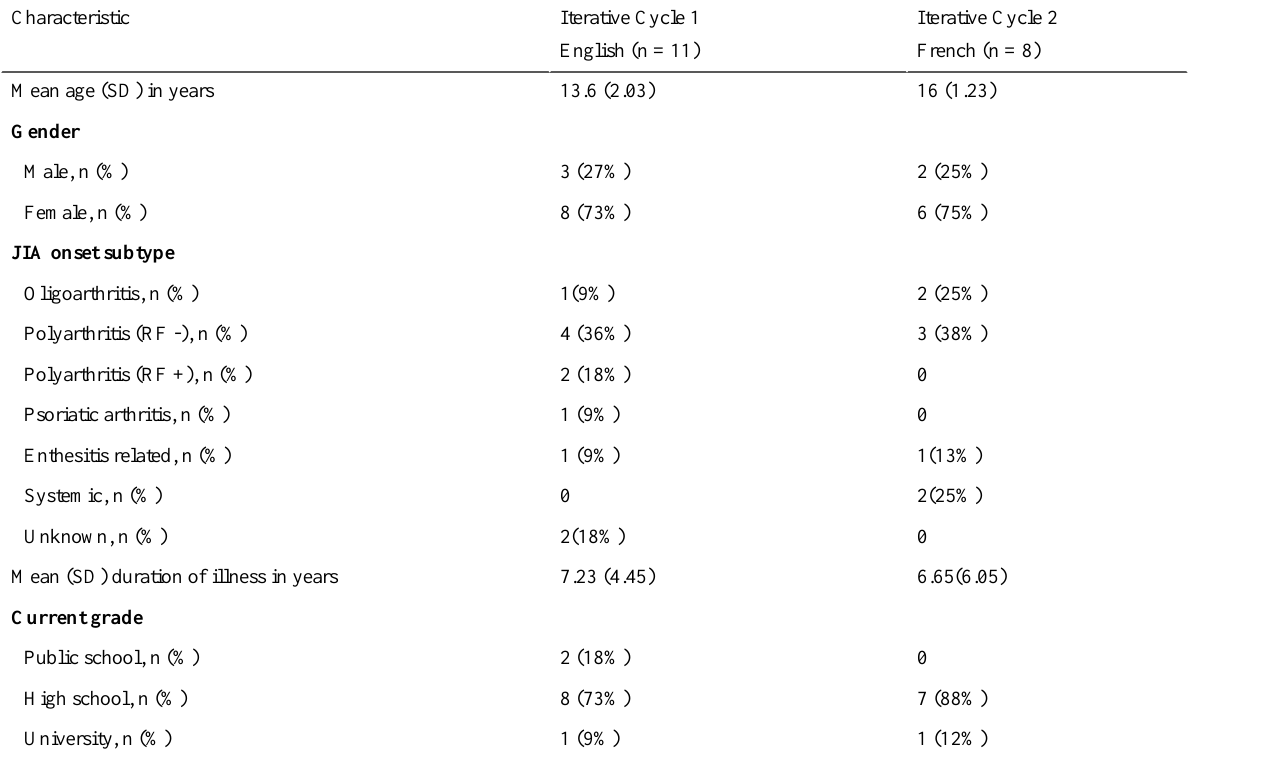
Table 1. Characteristics of the adolescents from interative cycles 1 and 2 (n =